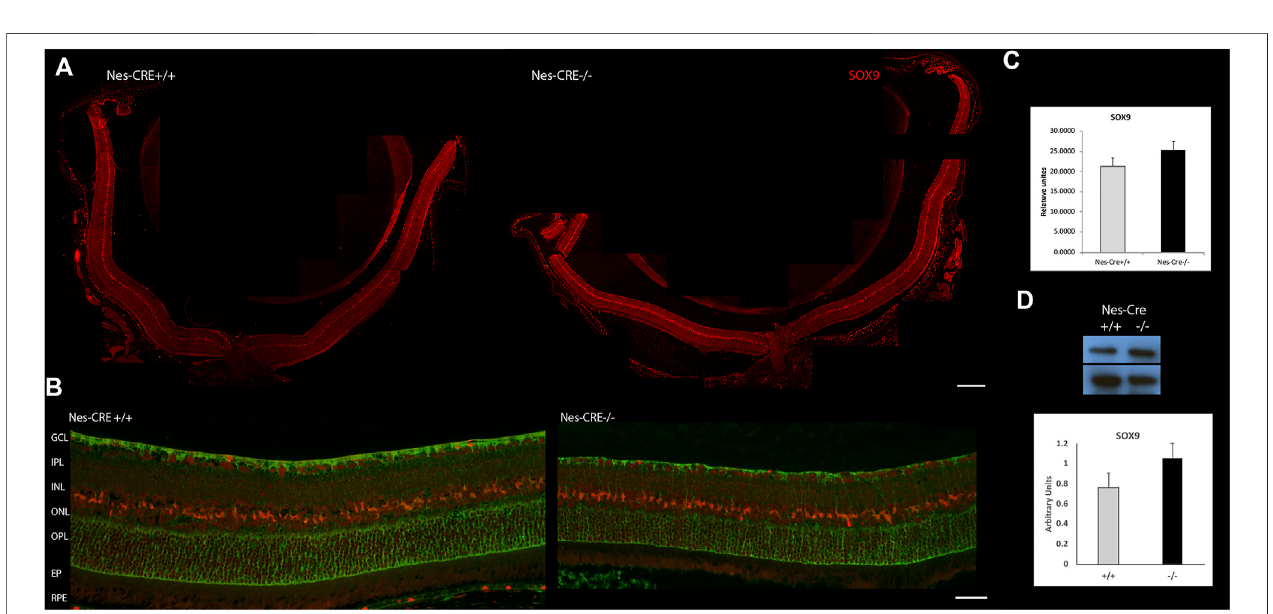
FIGURE5| SOX9levelsinretinasfrommicewithaconditionaldeletionofSIRT6fromtheCNS. (A) Representativeimmuno fl uorescenceofSOX9levels(red)inNes- Cre +/+ (left panel, n (cid:1) 4) and Nes-Cre − / − (right panel, n (cid:1) 5) whole retinal sections. Scale bar: 100 μ m. (B) Higher magni fi cation photos show colocalization of SOX9 with glutamine synthetase (green) in Müller cells and RPE. Scale bar, 50 μ m Ganglion Cell Layer (GCL), Inner Plexiform Layer (IPL), Inner nuclear Layer (INL), Outer Plexiform Layer(OPL),OuterNuclearLayer(ONL),RetinalPigmentEpithelium(RPE). (C) Fluorescenceintensitywasquanti fi edusingtheImageJprogram. (D) Representative Western blot of SOX9 levels from retinal extracts of Nes-Cre animals. β -actin was used for normalization. Quanti fi cation of bands was performed using the ImageJ program. Data are mean ± SE.